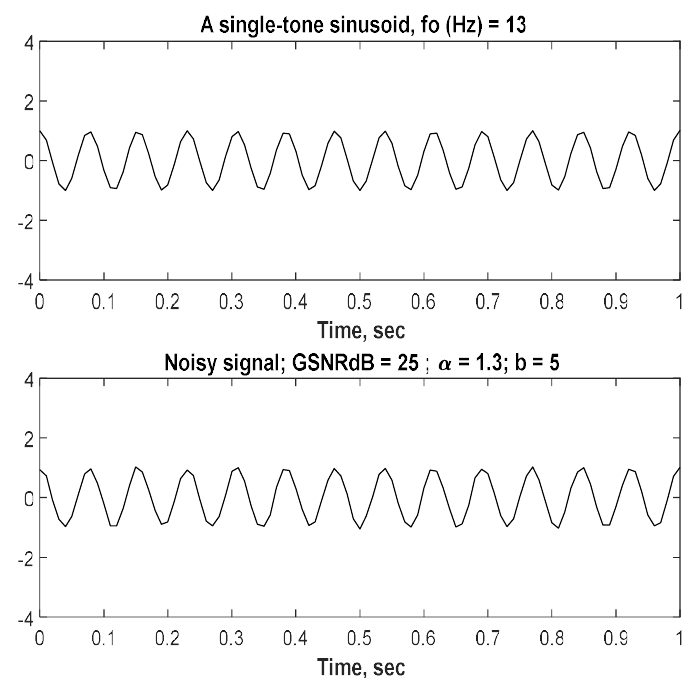
Figure 13. A single tone and noise signals.